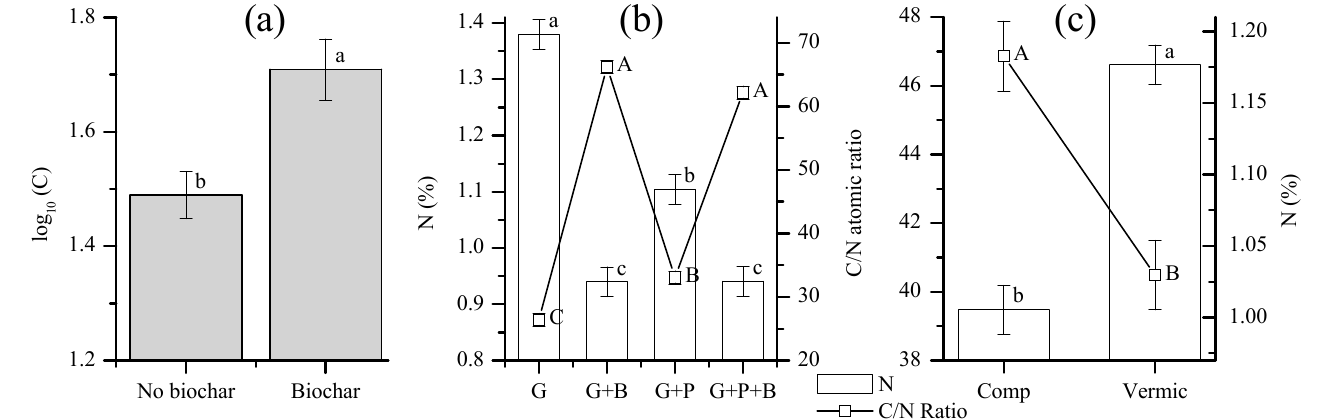
Figure 2. Biochar effect on C concentration ( a ), phosphate and biochar interaction effects on N concentration and on C/N ratio ( b ), and effects of vermicomposting on these variables ( c ). G: grass clippings; G + B: grass + biochar; G + P: grass + phosphate; and G + B + P: grass + biochar + phosphate; Comp: composting; and Vermic: further vermicomposting. Columns with the same lower-case letters (C and N) and symbols with the same upper-case letters (C/N ratio) indicate no statistical difference at p < 0.05 using Duncan test. Vertical bars denote standard errors.